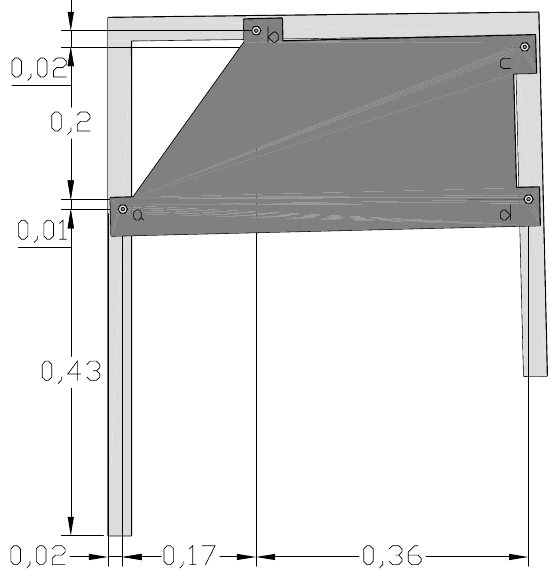
Fig. 1. Frame and plate coupled along four